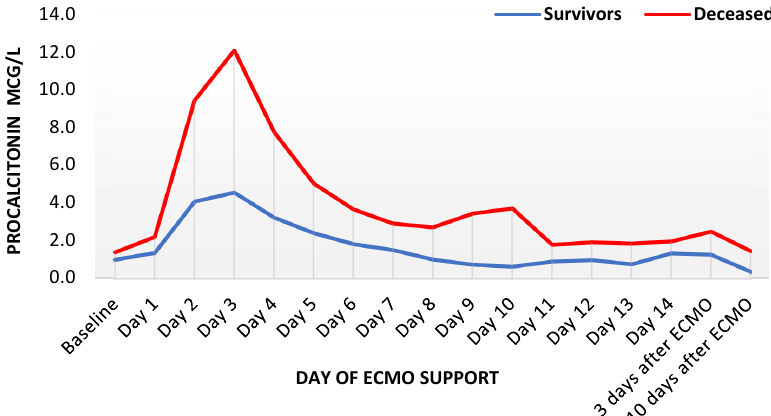
Figure 2. Trends of procalcitonin levels during ECMO support, presented as median values ( n = 435). ECMO: extracorporeal membrane oxygenation.